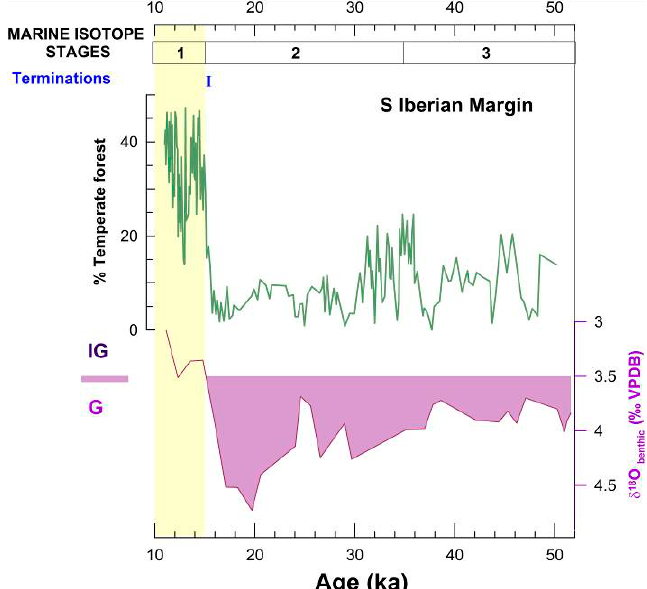
Figure 10. Shift between vegetation modes during the last glacial/interglacial transition, as recorded in the southern Iberian margin. In purple, benthic δ 18 O [79] indicates ice volume; the fill shows the glacial/interglacial threshold. In green, pollen from trees associated to temperate forest [114]. Marine isotope stages and terminations (in roman numerals) are represented on top. The yellow band highlights the interglacial stage.